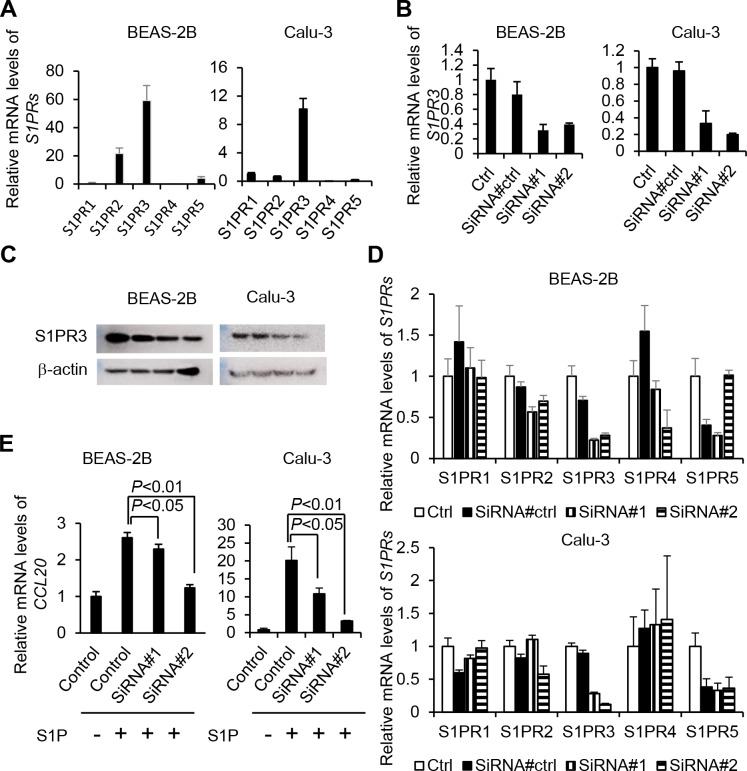
The assessment of role of S1PR3 in the bronchial epithelial cells.Relative mRNA levels of S1PRs in BEAS-2B and Calu-3 were analyzed by qRT-PCR (A). Gene expression knockdown of S1PR3 was performed by the two pairs of siRNA, as described in the Materials and Methods. Data are expressed as the mean ± SEM (B). Protein levels of S1PR3 after the treatment of siRNA in BEAS-2B and Calu-3 were analyzed by western blot analyses (C). Relative mRNA levels of S1PRs after the treatment of siRNA in BEAS-2B and Calu-3 were analyzed by qRT-PCR (D). Relative mRNA levels of CCL20 were analyzed by qRT-PCR in BEAS-2 and Calu-3 that had been treated with two pairs of siRNA of S1PR3 and stimulated by PBS or 1 μM S1P for 2 h. Data are expressed as the mean ± SEM (E).